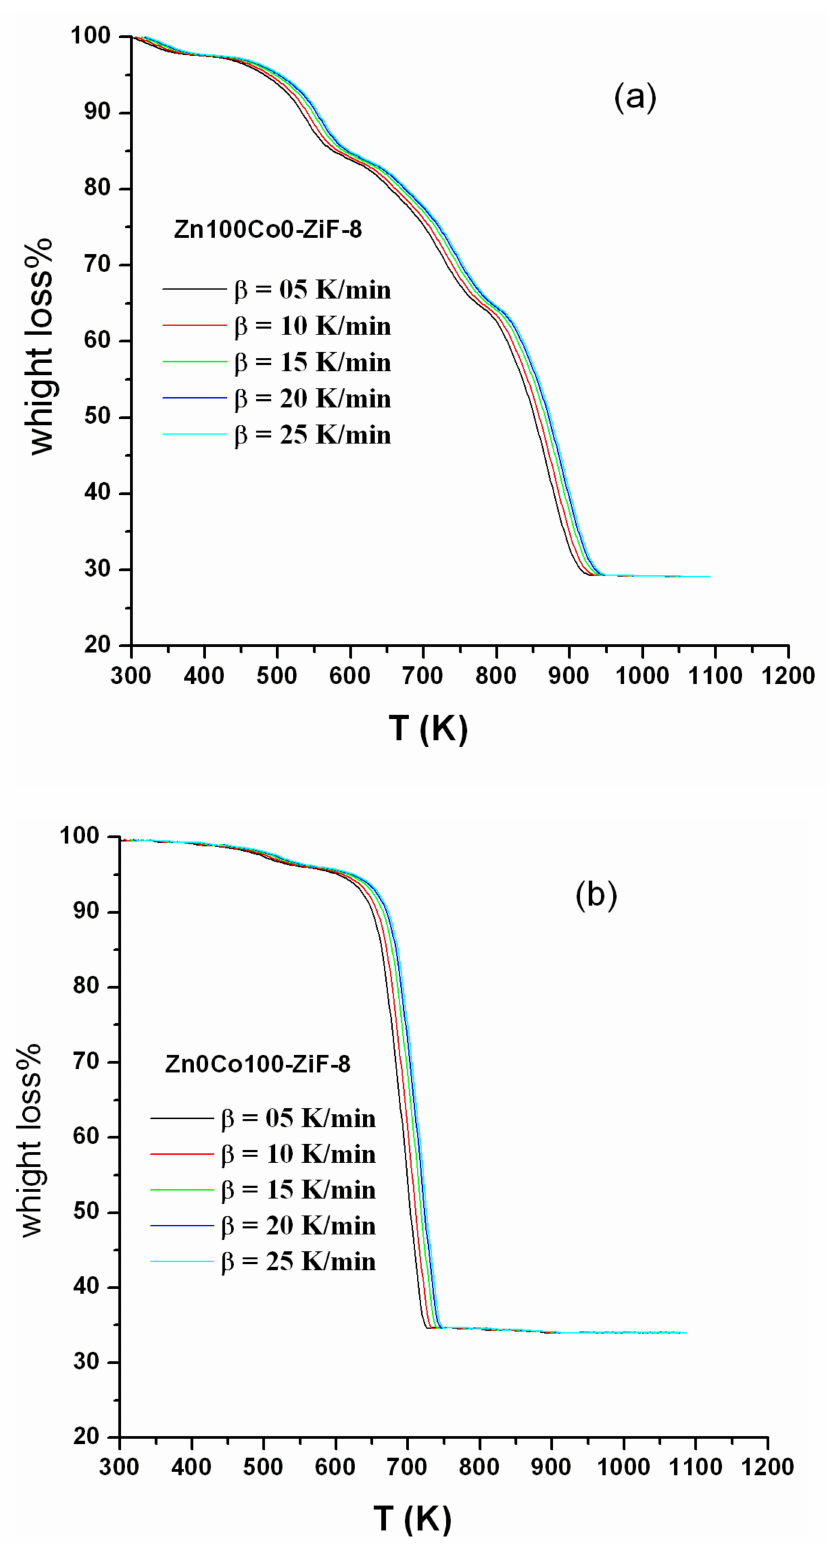
Figure 3. TGA curves for ( a ): Zn100Co0-ZIF-8 and ( b ): Zn0Co100-ZIF-8 with the different heating rates (5, 10, 15, 20, 25